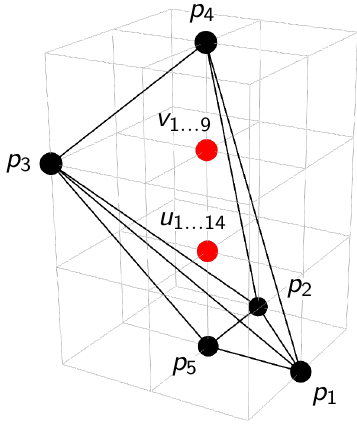
Figure 17 . Toric diagram of Y 3 , 2 ( CP 2 )